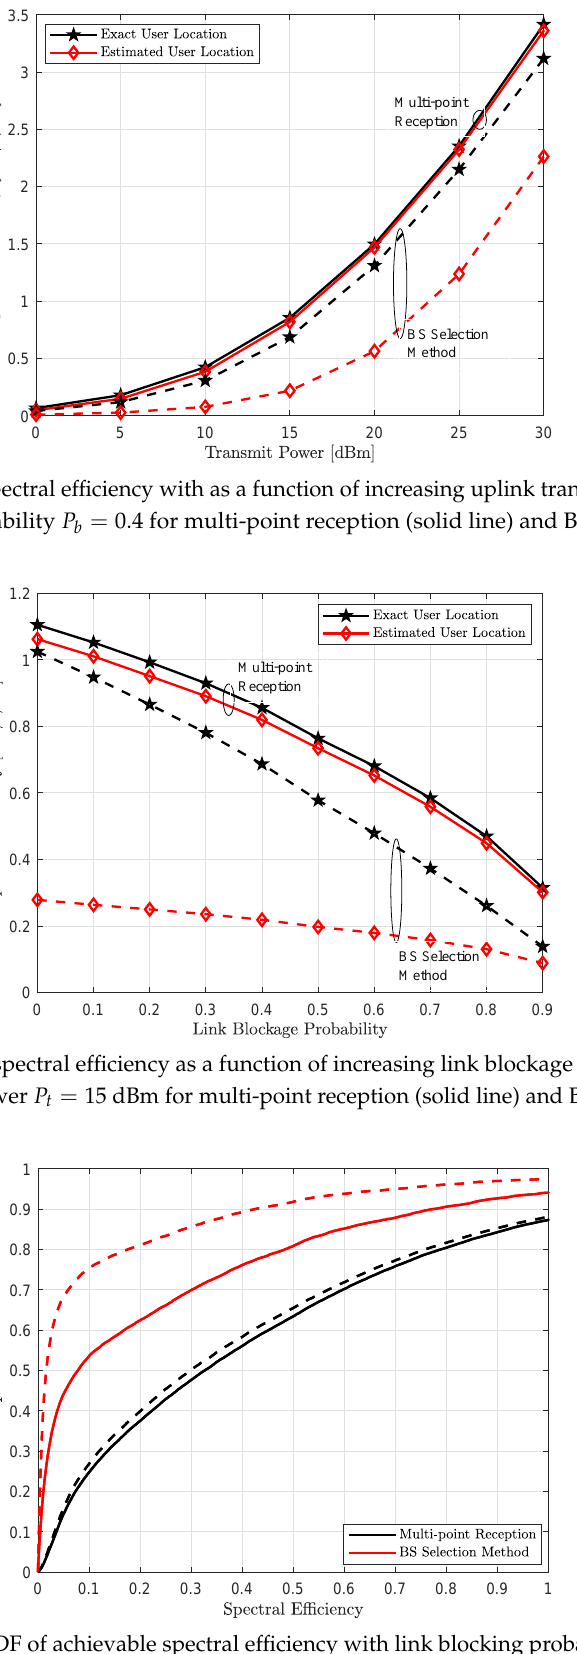
Figure 11. Empirical CDF of achievable spectral efficiency with link blocking probability P b = 0.8 and uplink transmit power P t = 15 dBm for exact user location (solid line) and estimated user location (dashed